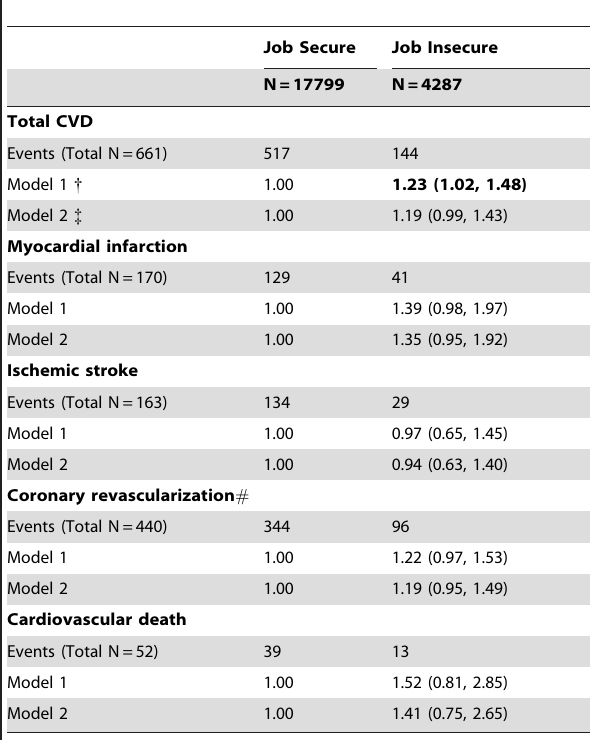
Table 3. Hazard rate (HR) and 95% confidence interval of cardiovascular disease by job insecurity (N